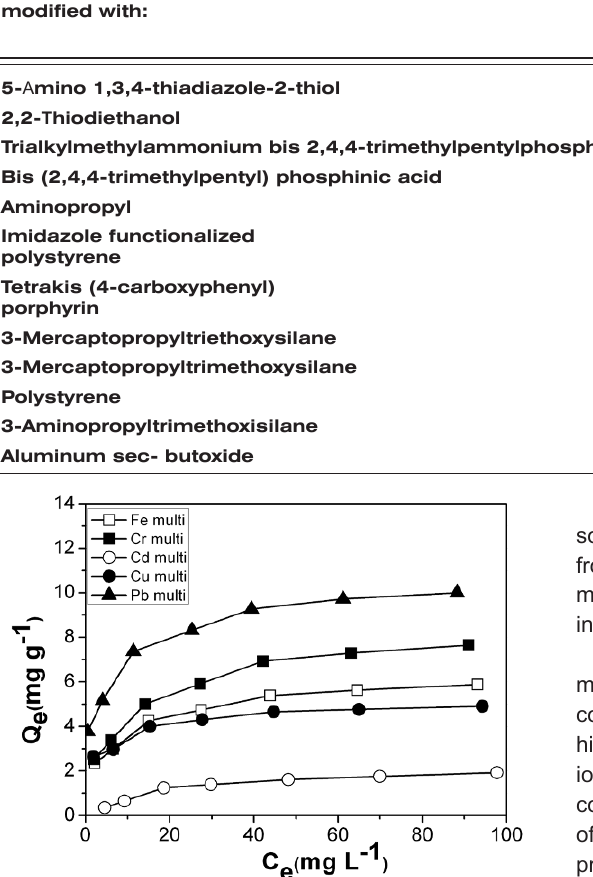
Table 3. Comparison of the adsorption capacities for Pb(II), Cu(II) and Cr(III) in the present study with those reported in the literature Silica based adsorbent modified